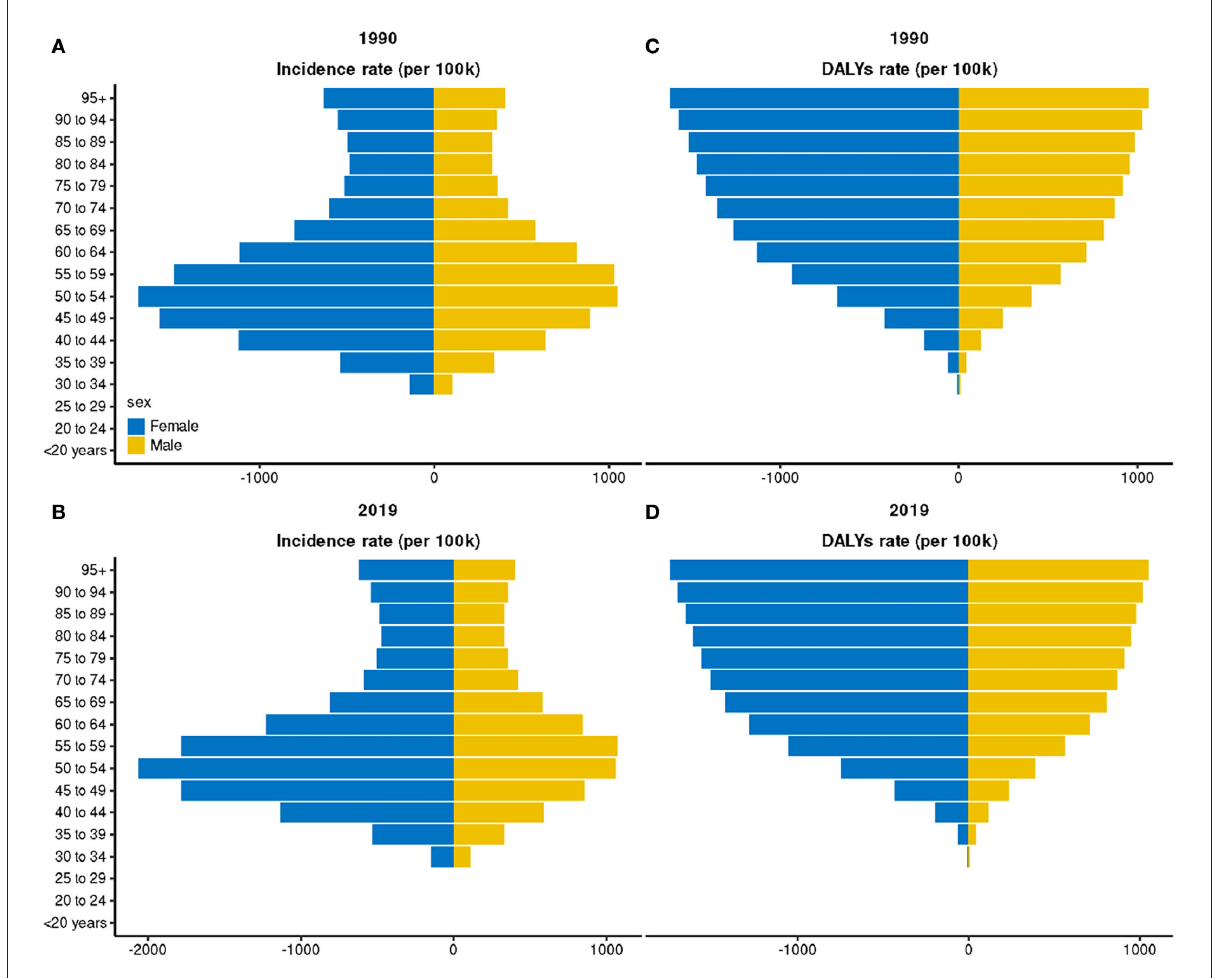
FIGURE1 Incidence and disability-adjusted life year (DALY) rate of hand osteoarthritis in different sex and age groups. (A) Incidence rate in 1990; (B) Incidence rate in 2019; (C) DALY rate in 1990; and (D) DALY rate in